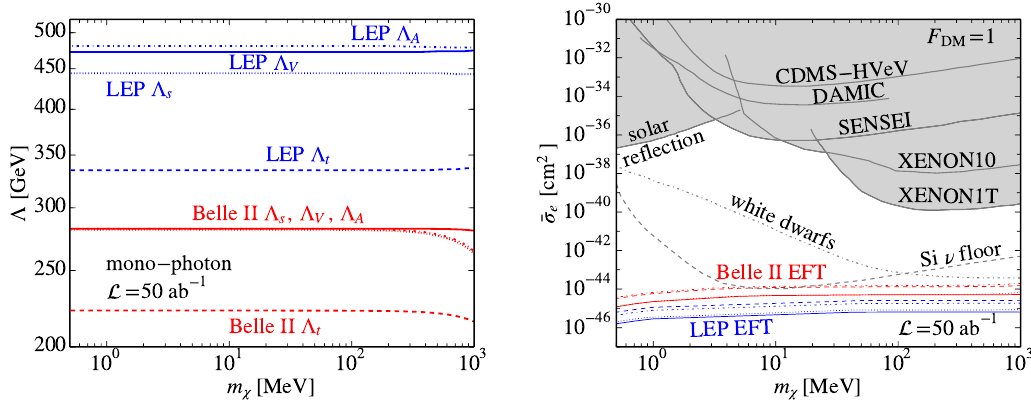
Figure 1 . Left panel: Belle II 90% C.L. lower bounds (red curves) on the new physics scale Λ A (dot-dashed), Λ (solid), Λ (dotted), and Λ (dashed), in the EFT operators as a function of V s t the DM mass, via the mono-photon channel with the integrated luminosity 50 ab − 1 . The LEP constraints (blue curves) [39] with the luminosity of 650 pb − 1 are also shown. Right panel: Belle II and LEP constraints on the DM-electron cross section at the reference momentum q = αm for e the EFT operators, as well as constraints from DMDD experiments with F ( q ) = 1 , including DM XENON10 [5], CDMS-HVeV [72], XENON1T [6], DAMIC [73], and SENSEI [74]. Constraints for boosted DM from solar reflection [22] and constraints on dark matter capture in white dwarfs are also shown. We compute the white dwarf limit at the reference momentum q = αm by using the e lower bound on Λ given in ref. [13]. The dashed gray line shows the neutrino floor limit for silicon target detectors where the exposure is 1000 kg-year